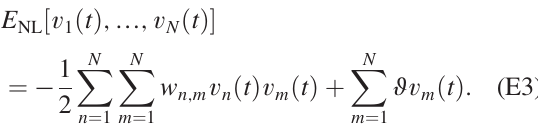
FIG. 10. Monotonicity of the effective somatic input ¯ F monotonicity of [Eq. (23)] for B ¼ 2 , PN − 1 Var ½ w (cid:1) ¼ 0 . 8